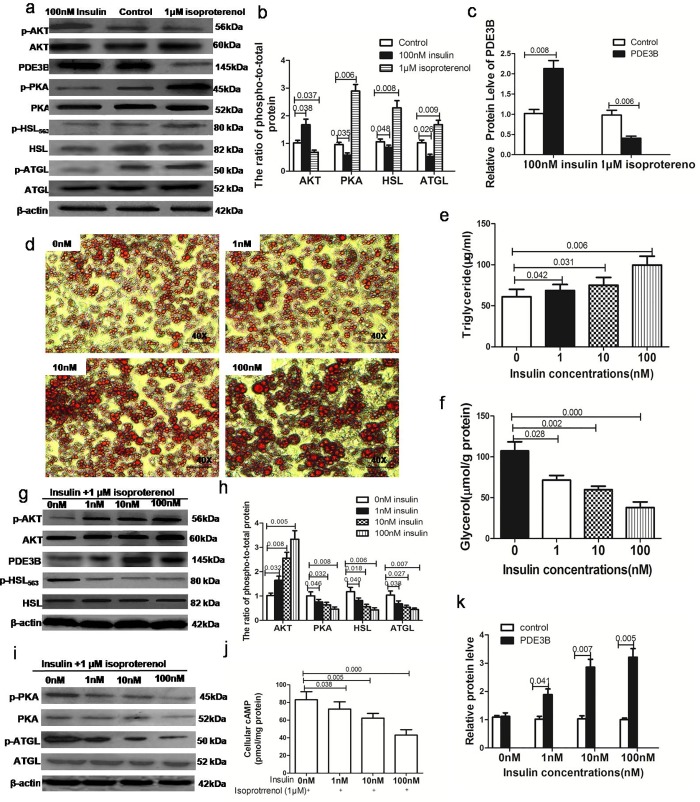
Insulin inhibits isoproterenol-stimulated lipolysis in 3T3-L1 adipocytes via the AKT/PKA/HSL pathway.We treated differentiated adipocytes with 100 nM insulin and 1 μM isoproterenoland examined the effects on lipolysis(in triplicate). (a)Western blot analyses ofAKT, PDE3B, PKA, HSL and ATGL protein levels in the insulin, isoproterenol and control groups. Phosphorylated AKT (p-AKT), phosphorylated PKA (p-PKA), phosphorylated HSL (p-HSL) and phosphorylated ATGL (p-ATGL) expression was normalized to their total protein level as a loading control. (b)The phosphorylated protein/total protein ratios of AKT, PKA and HSL were calculated, and the control ratio was normalized to 1. (c)Western blot analyses of PDE3B protein levels in the insulin, isoproterenol and control groups. Differentiated 3T3-L1 adipocytes were treated with different doses of insulin (1, 10,100 nM) and 1 μM isoproterenol for 24 h(in triplicate). (d) Cellular triglycerides were stained with Oil red O. Bar, 50 μm. (e) The amount of lipids was quantified by the Oil red O staining technique. (f)The concentration of glycerol in the medium was detected in different groups(g, i)Western blot analyses of AKT, PDE3B, PKA, HSL and ATGL protein levels in different groups. Phosphorylated AKT (p-AKT), phosphorylated PKA (p-PKA), phosphorylated HSL (p-HSL) and phosphorylated ATGL (p-ATGL) expression was normalized to their total protein level as a loading control. (h) The phosphorylated protein/total protein ratios were calculated, and the control ratio was normalized to 1.(j)cAMP levels in different groups. (k) The expression of PDE3Bwas determined in different groups by Western blot.